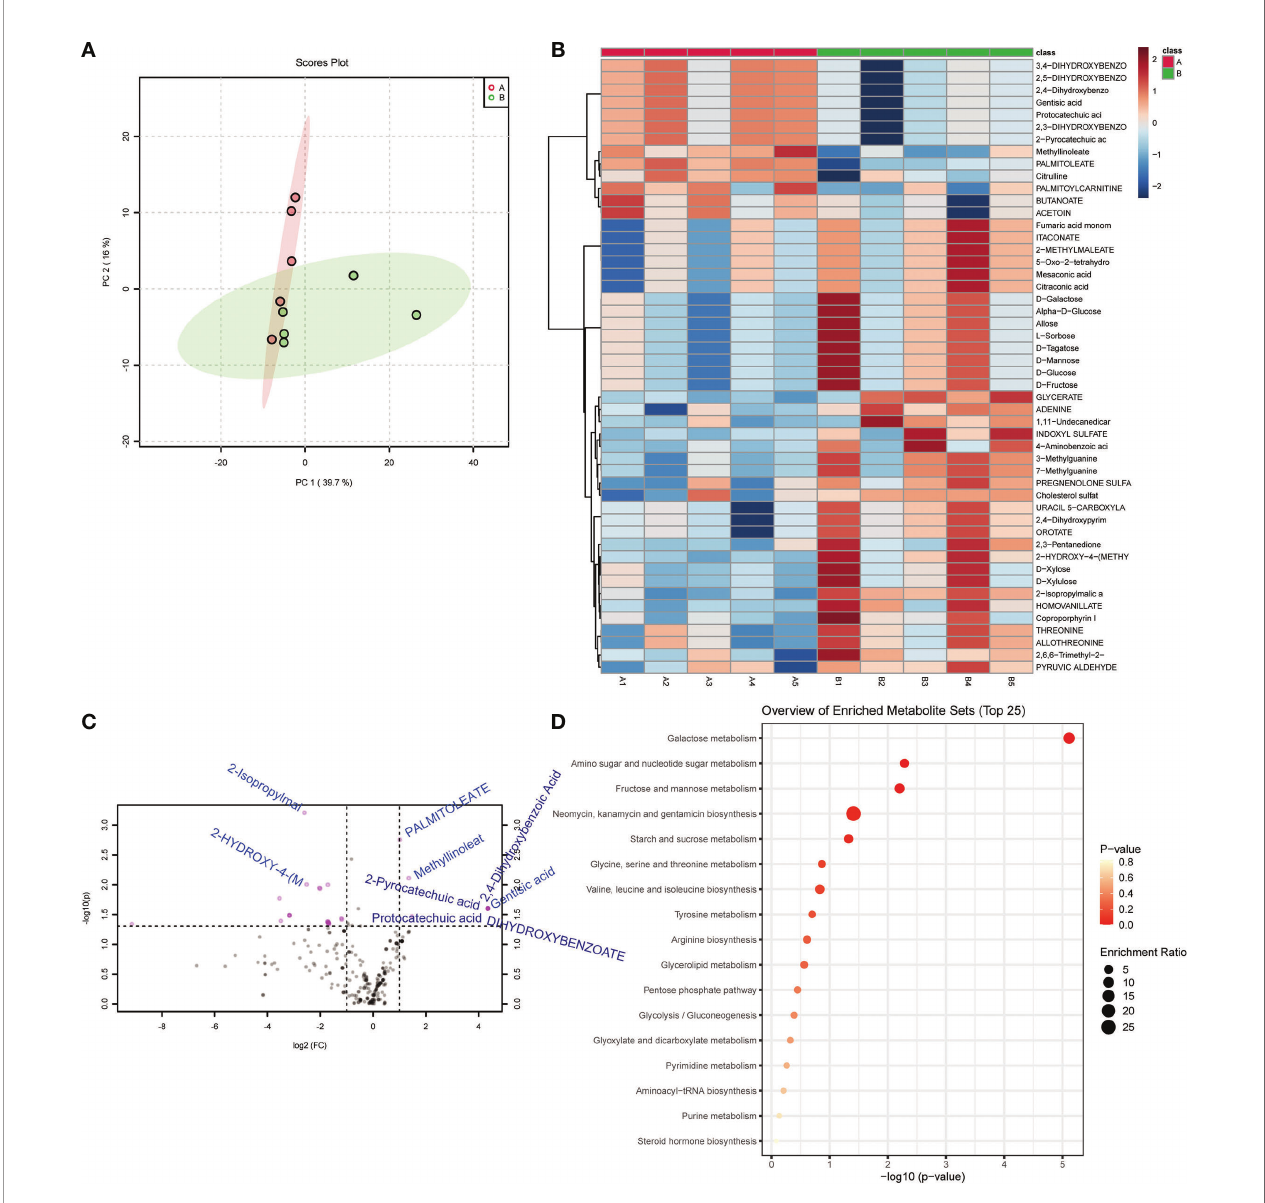
FIGURE 2 | Gut metabolites and functional changed in mice with acute pneumonia (n=10 mice/group). (A) PCA analysis of sample differences between control group and model group. (B) Heatmap showed changes in metabolite abundance. (C) Volcanograms showed differential metabolites. (D) Bubble map showed metabolite functional pathways. N=5 sample/group for Non-targeted Metabolomics